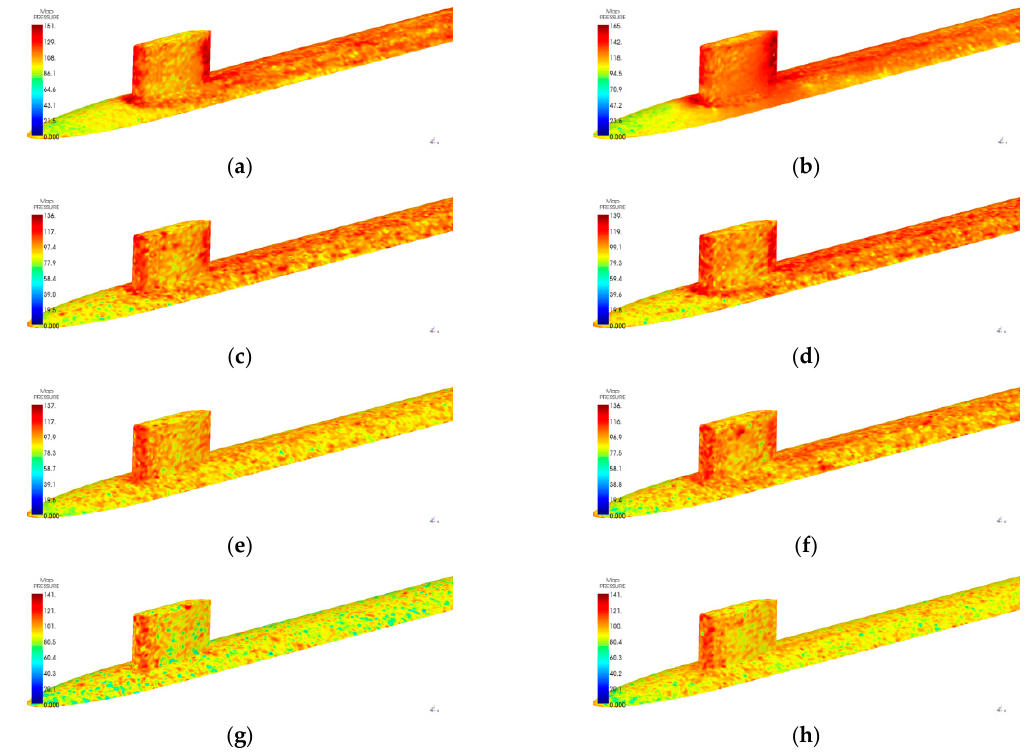
Figure 9. Distribution of the fluctuation pressure on the surface of the model at different frequencies: ( a ) f = 50 Hz; ( b ) f = 200 Hz; ( c ) f = 400 Hz; ( d ) f = 600 Hz; ( e ) f = 800 Hz; ( f ) f = 1000 Hz; ( g ) f = 1600 Hz; and ( h ) f = 2000 Hz. The left color bar shows the magnitude of the fluctuation pressure.